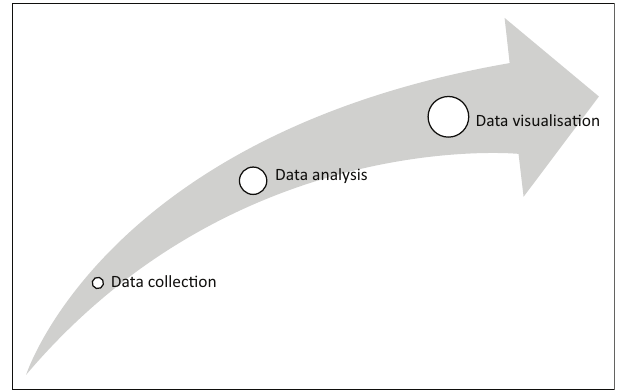
FIGURE 5: Stages of Big Data.